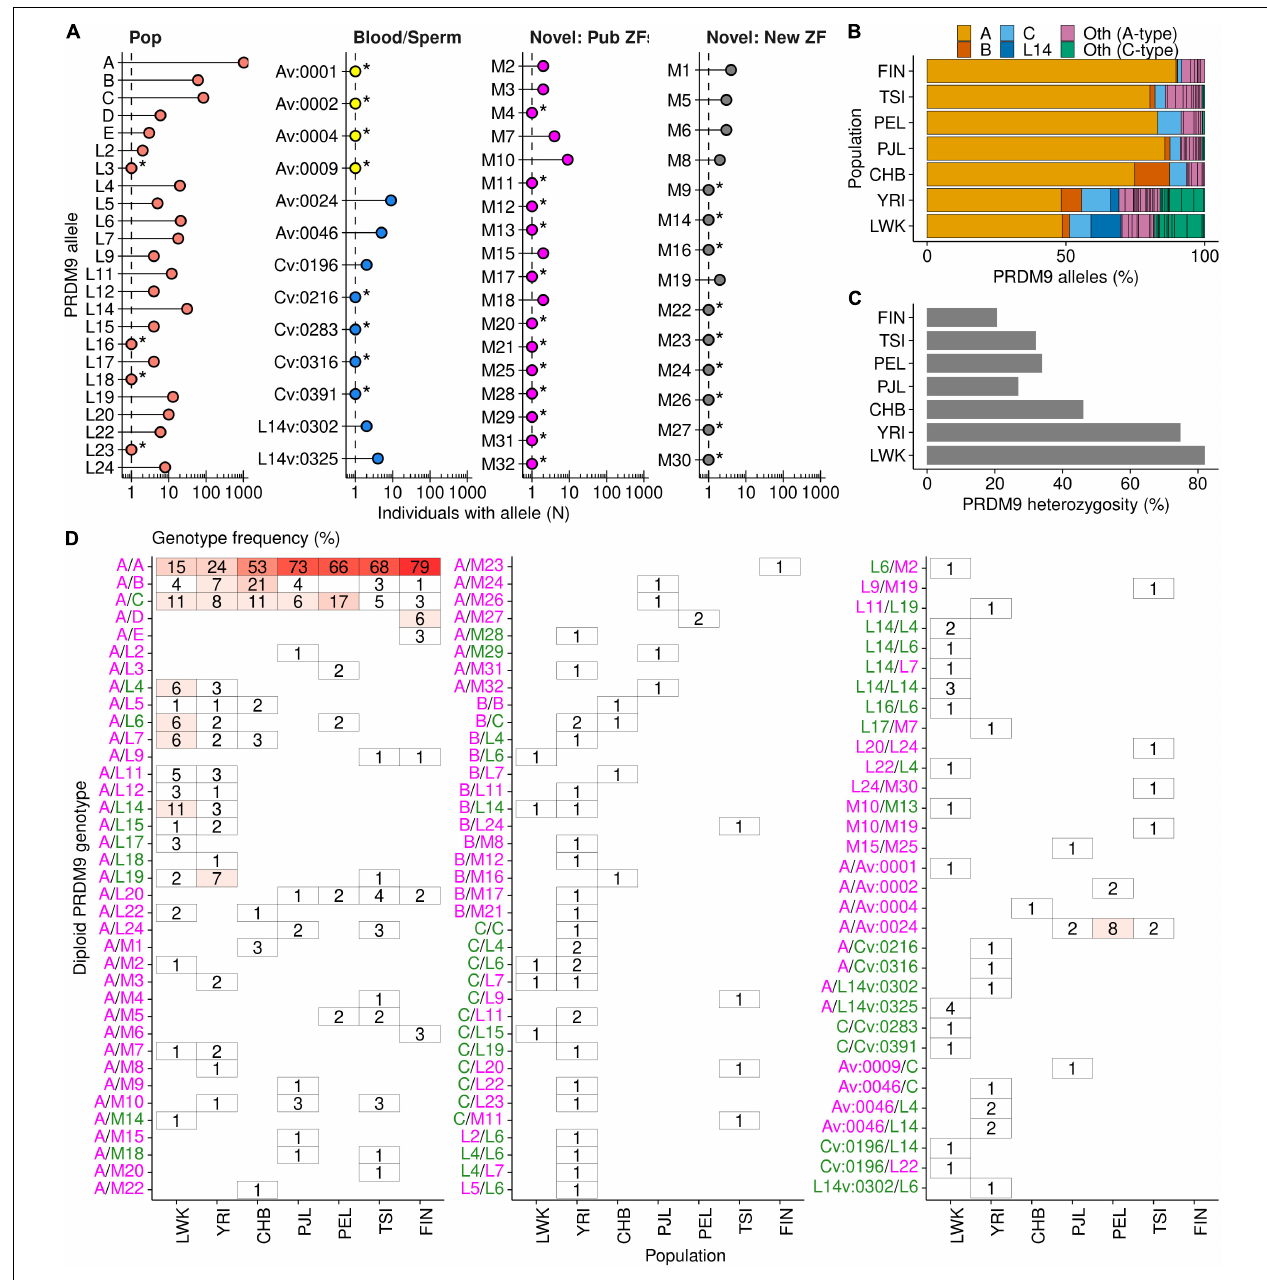
frequency of the C allele in the TSI and PJL populations was lower (fC TSI = 4%; fC PJL = 4%), but within the expected range of sampling error for the YRI, LWK, PEL, and CHB